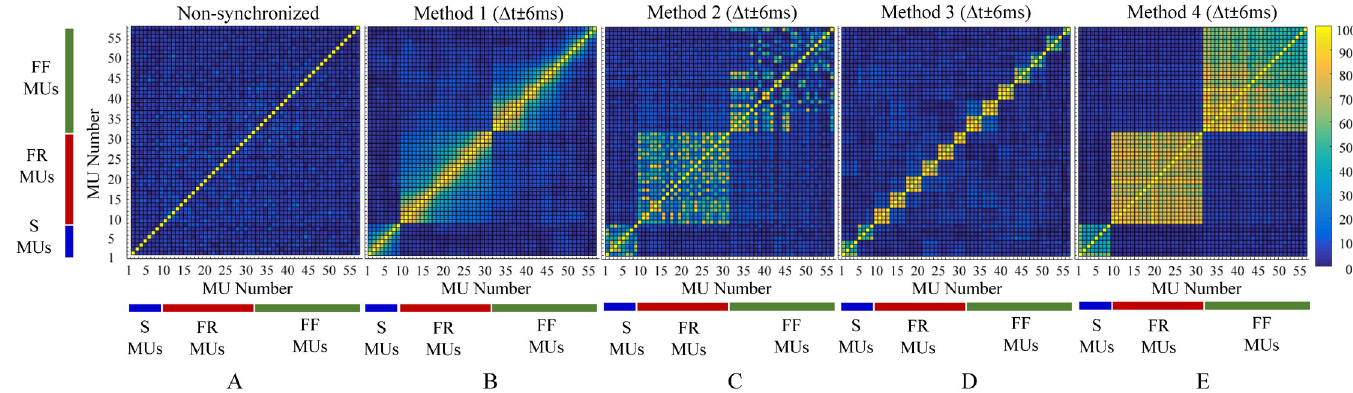
Fig 5. The correlation coefficients ( corMU ) between all pairs of 57 MU firing patterns for the NS model and for the four methods of MU synchronization using Δ t ± 6 ms. The color map represents corMU values in the range of 0% to 100% calculated within the square grid (57 × 57) of sequential MU numbers from 1 to 57. The diagonal elements of the color map correspond to a 100% correlation between the firing pulses of identical MUs.